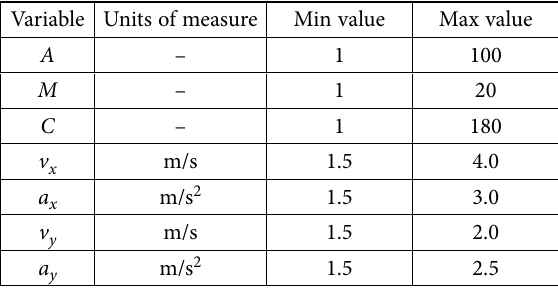
Table 1. Design variables parameters used during the